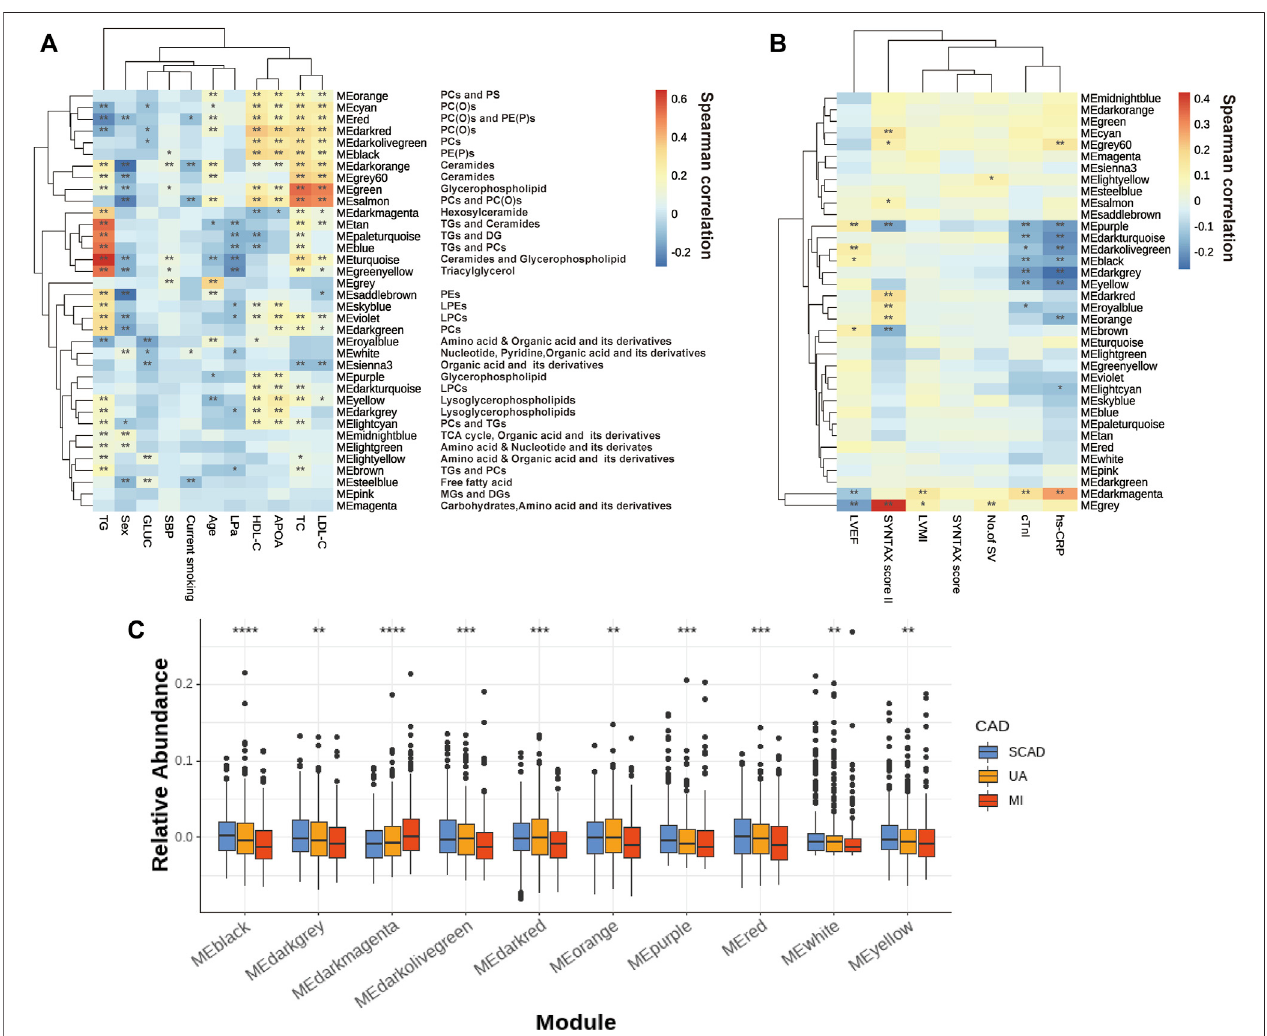
FIGURE 2 | Assessment of the metabolite modules associated with the CAD progression. (A) Heatmap of metabolite modules and major CAD risk factors. (B) Heatmap of metabolite modules and major CAD phenotypes. (C) Boxplot of 10 signi fi cantly altered metabolite modules between CAD subgroups compared by the Wilcoxon rank sum test. In (A,B) , the colors varying from blue to orange indicate negative to positive correlations, and *FDR < 0.05, **FDR < 0.01 by the spearman correlation. In (C) , boxes represent the inter-quartile ranges, lines inside the boxes denote medians and the asterisk represents p values < 0.05 by the Wilcoxon rank sum test. APOA, apolipoprotein A; GLUC, glucose; HDLC, high-density lipoprotein cholesterol; LDLC, low-density lipoprotein cholesterol; LP(a), lipoprotein(a); LVEF, left ventricular ejection fraction; LVMI, left ventricular mass index; No. of SV, No. of stenosed vessels; SBP, systolic blood pressure; TC, total cholesterol; TG, triacylglycerol; other abbreviations as in Figure 1